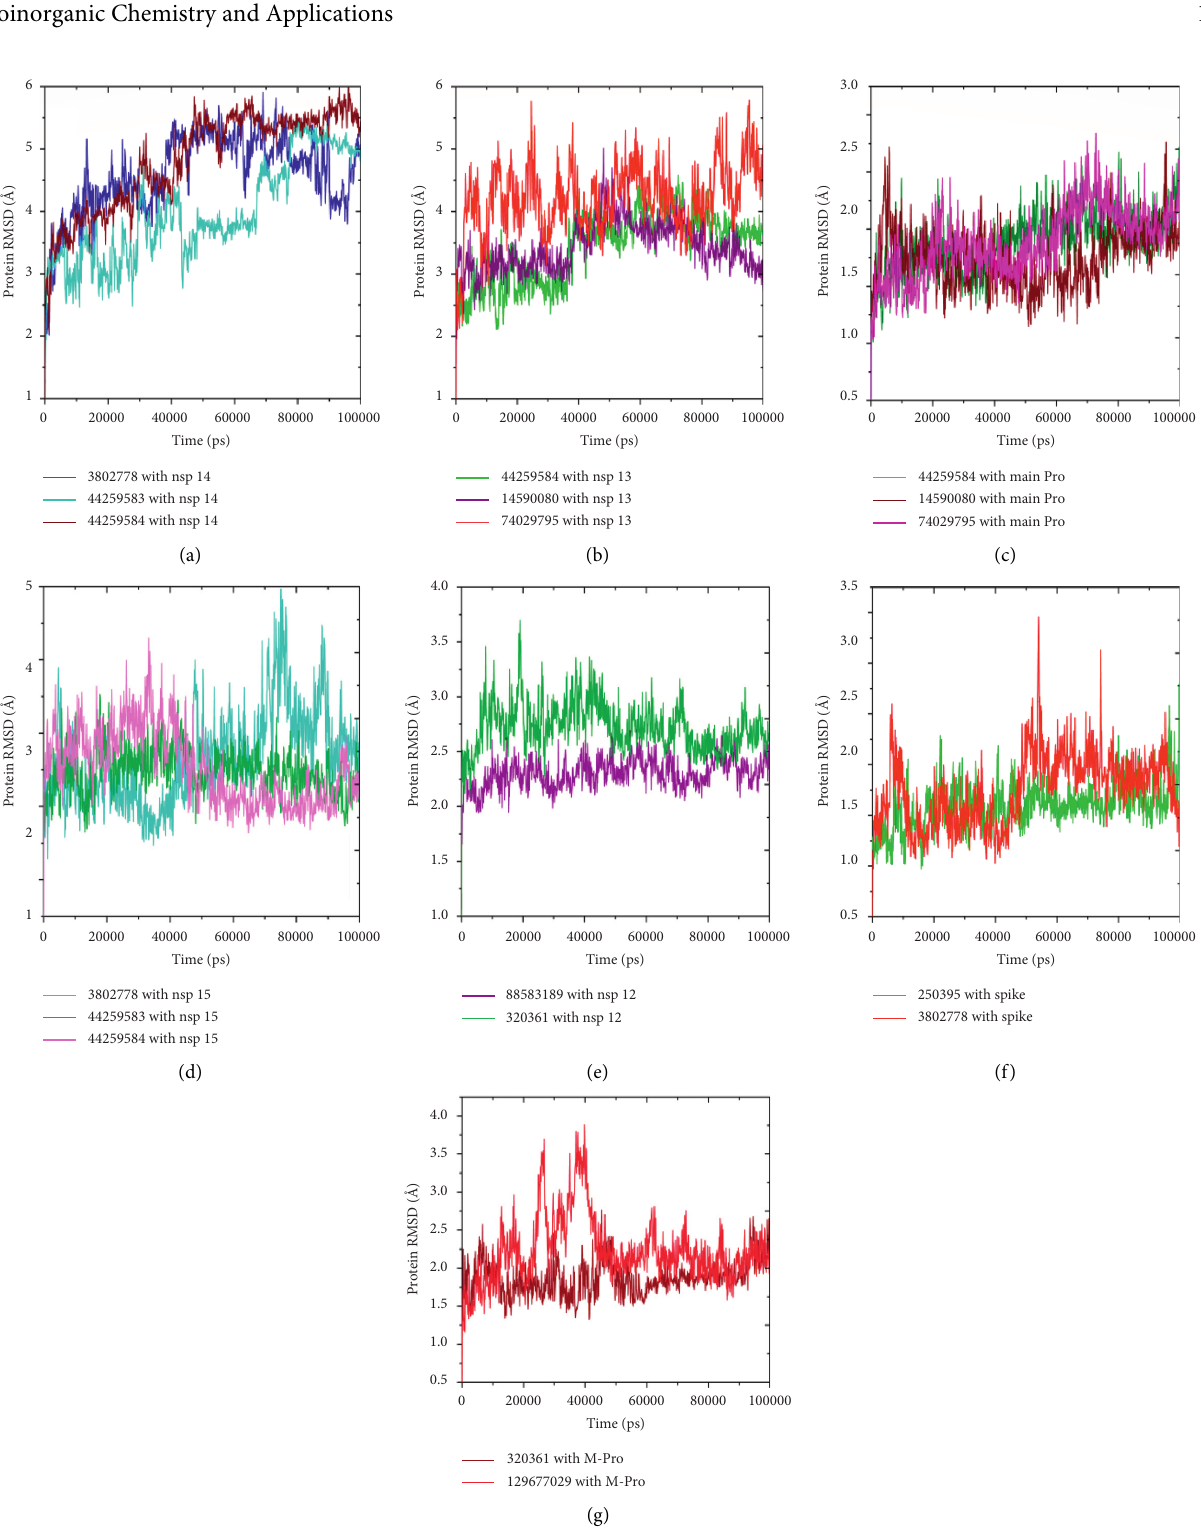
Figure 7: RMSD plot of SARS-CoV-2 proteins and screened compound complexes. Nsp14 (a), Nsp13 (b), main protease (c), Nsp15(d), Nsp12 (e), spike (f), and membrane protein